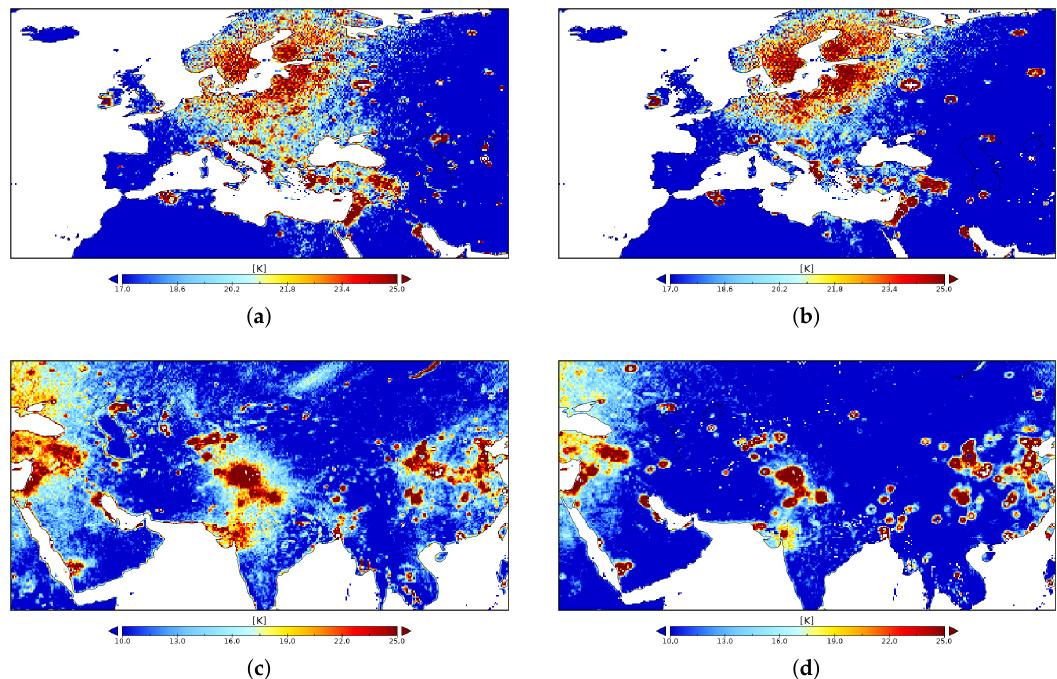
Figure 11. Zoom in of the error standard deviation maps shown in Figure 10: ( a , c ) SMOS nominal and ( b , d ) SMOS NS. Note the change of scale with respect to the one used in Figure 10. Histograms of the differences between error standard deviations of SMOS nominal and SMOS NS are shown in Figure 13a for the global map and in Figure 13b for the region that is more affected by RFI contamination, covering Europe, Asia, and north Africa (longitude range (20 W, 180 E), latitude range (10 N, 80 N)) (see Figure 9). Statistics show that NS reduces SMOS TB errors over strongly RFI-contaminated regions (mean error reduction approximately 1.5 K ) and generally improves TB quality (approximately 75% of the gridpoints over land present lower errors for NS TBs than for the nominal ones). Similar statistics are obtained when considering the global map, although the mean error reduction is decreased. The impact of NS is lower over RFI-free regions, but it is still beneficial since it reduces overall ripples in TB images. In the case of SMAP, error estimates for 15% of the gridpoints have not converged to a meaningful value (white shading in Figure 10c). A refinement of the TC analysis is proposed in Section 3.2.1 to obtain error estimates for the global